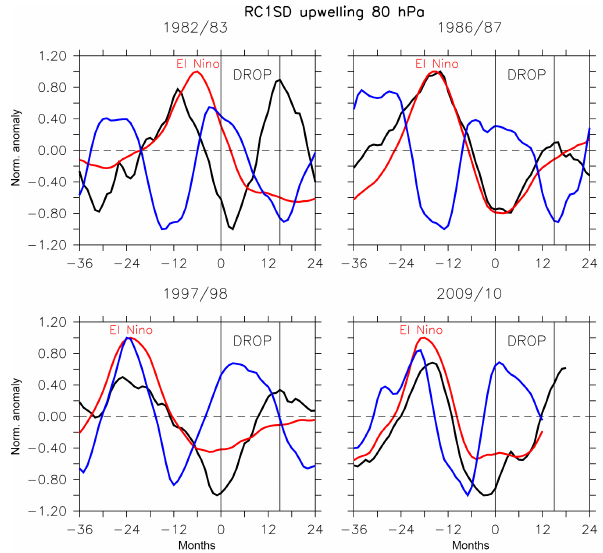
Figure 11. Episode analysis for the normalized upwelling anomaly (black) for (10 ◦ N–10 ◦ S) at 80hPa, the max-normalized SST anomaly for the El Niño index 3.4 region (red), and the max- normalized QBO (blue) for (10 ◦ N–10 ◦ S). The normalized up- welling anomaly is calculated by division of either the maximum or the absolute value of the minimum. For the SSTs and the QBO it is defined accordingly. Therefore, the results are dimensionless. All episodes are referenced to the beginning of the temperature drop. The drop onsets are accompanied by a negative upwelling